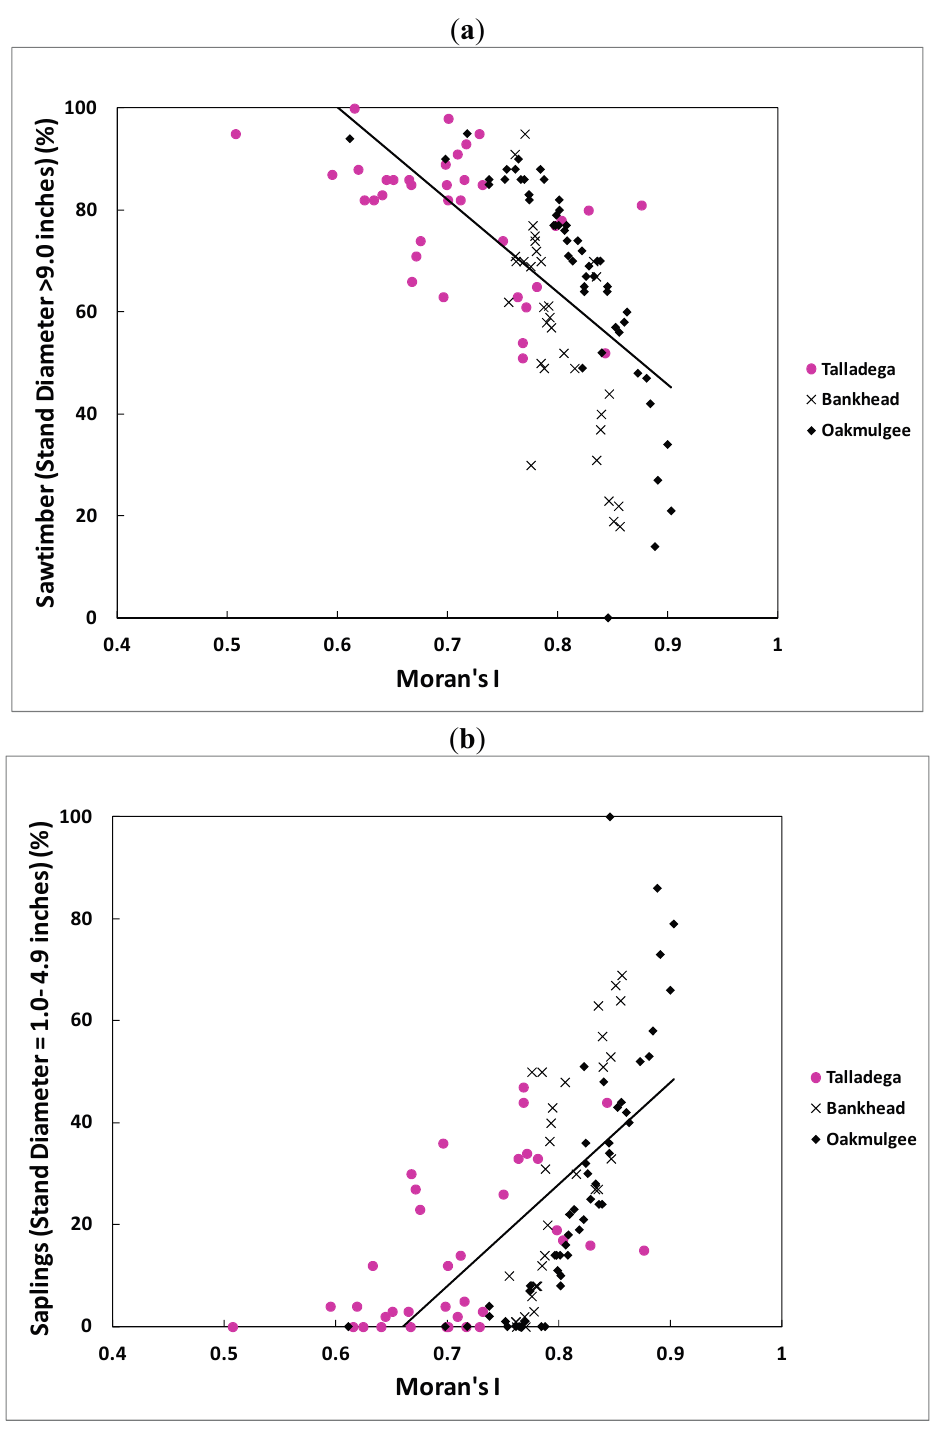
Figure 5. Linear Regression Prediction Models Using Moran’s I: ( a ) Sawtimber ( b )